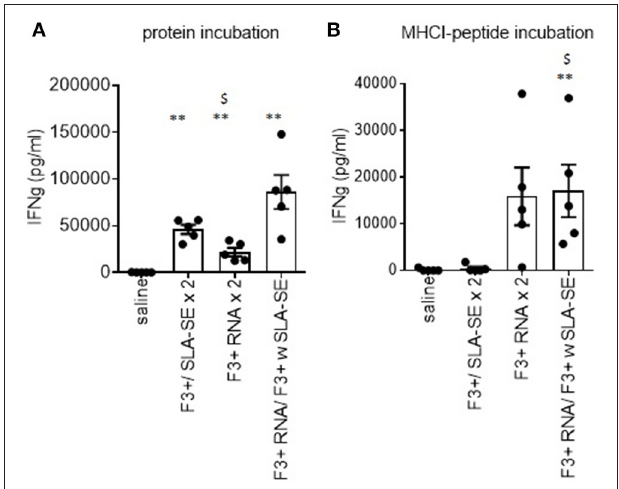
FIGURE 6 | Protection against L. donovani infection by a heterologous prime-boost immunization regimen. C57BL/6 mice were immunized with the indicated homologous or heterologous regimen of F2-containing vaccines. Mice were infected by intravenous inoculation of L. donovani parasites 4 weeks after their final, or only, immunization. Four weeks after infection, livers were removed and parasite burden determined for each animal by PCR. Data are shown as mean and SEM, n = 7 per group. * = p -value < 0.05 when comparing the indicated group against the saline injected control